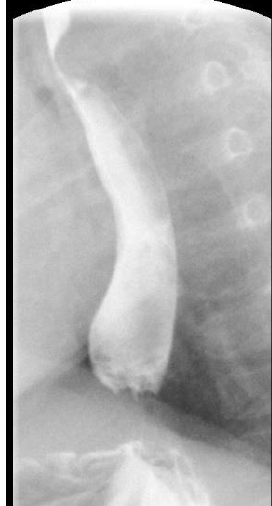
Figure 2. A lateral projection of an upper gastrointestinal imaging study in a 21 months old girl with posterior fossa malformations – hemangiomas – arterial anomalies – cardiac defects – eye abnormalities